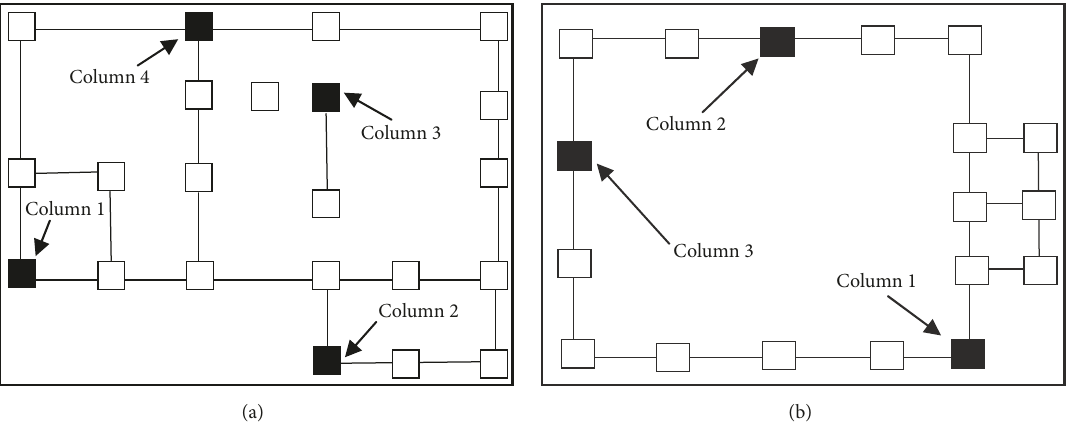
Figure 7: Schematic sketch for (a) Object I and (b) Object